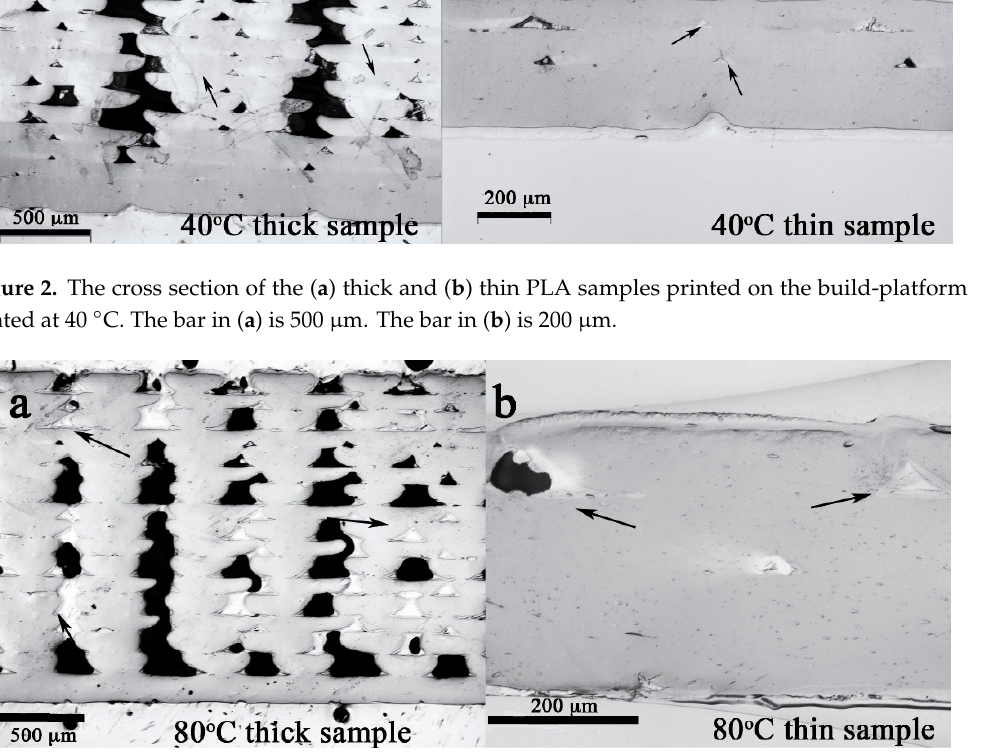
Figure 3. The cross section of the ( a ) thick and ( b ) thin PLA samples printed on the build-platform heated at 80 °C. The bar in ( a ) is 500 μ m. The bar in ( b ) is 200 μ m.